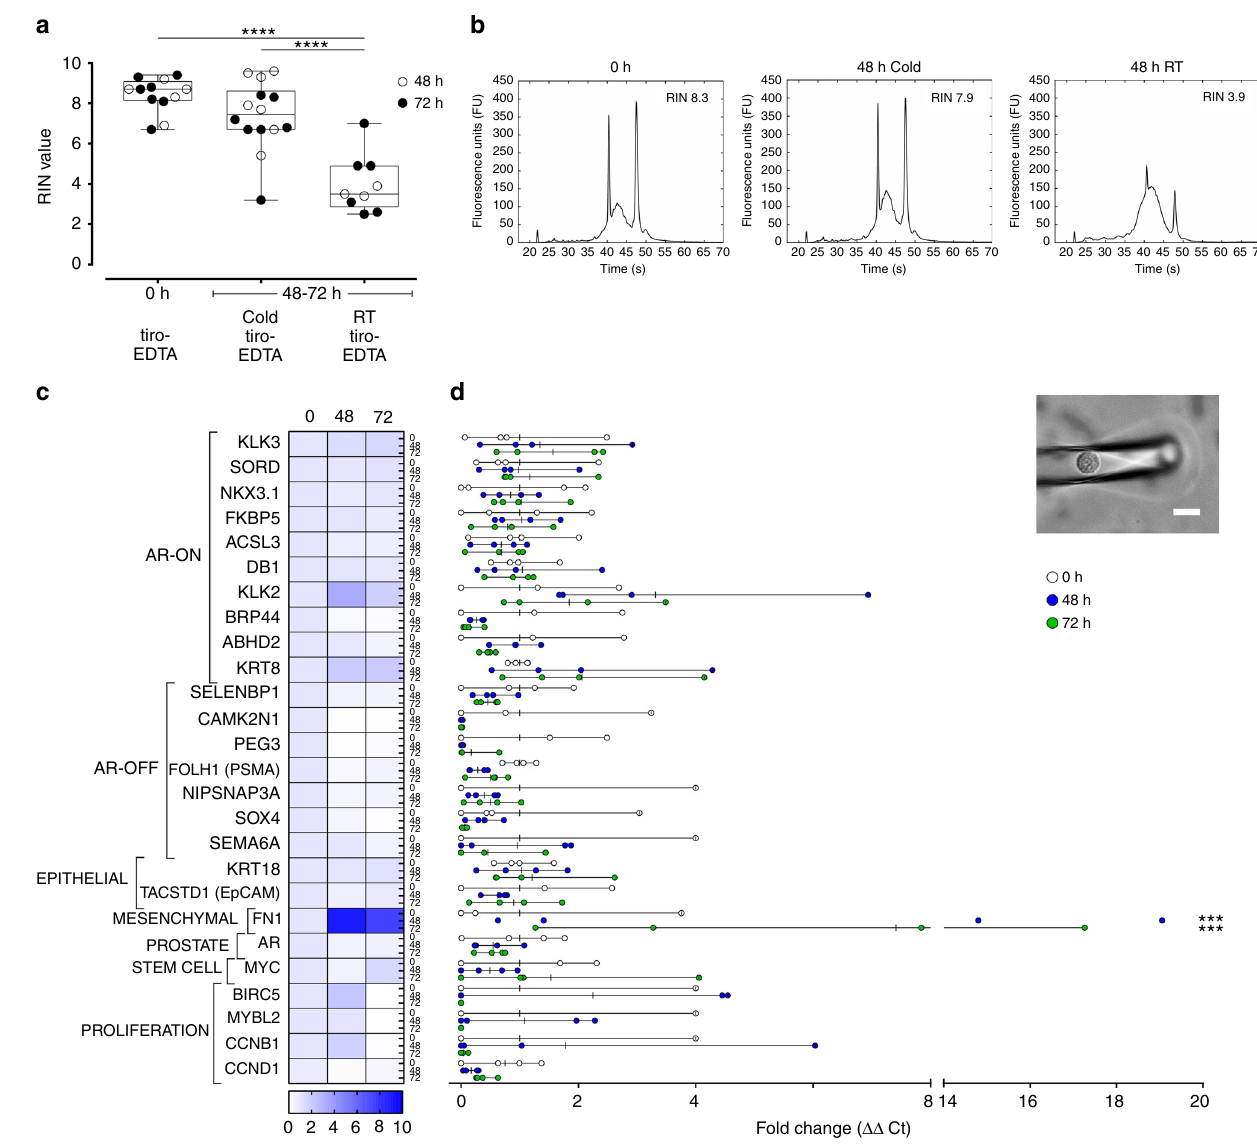
Fig. 4 LNCaP cells spiked into healthy donor blood and isolated from the CTC-iChip contain intact RNA for molecular pro fi ling after up to 72 h of preservation. a RIN values of isolated LNCaP cells from fresh and stored blood (**** p < 0.0001; one-way ANOVA followed by Tukey ’ s post test). b Representative electropherograms showing the size distribution traces of total RNA. Cells isolated from RT-stored blood contain highly fragmented RNA. In contrast, cells isolated from fresh and cold-stored blood contain intact RNA with distinct 28S/18S ribosomal peaks. c Heatmap and d fold change (relative to 0 h) of a panel of 26 prostate cancer genes in single LNCaP cells (picked from the CTC-iChip product; inset) comparing 0-, 48-, and 72-h cold storage (*** p < 0.001; two-way ANOVA followed by Dunnett ’ s post test). Heatmap in c represents the average expression across single cells, and data points in d represent individual cells. Scale bar represents 20 μ m. Box-and-whiskers plots show median, interquartile range, maxima, and